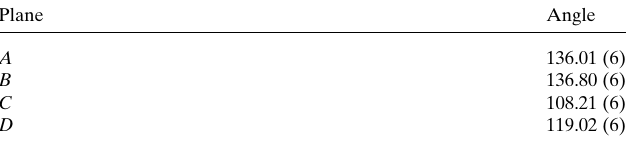
Table 2 Conformation of the four aromatic walls of the calix[4]arene host ( (cid:4) ). A – D are the mean planes passing through the four phenyl moieties of the host. The values reported are the angles formed with the mean plane passing through atoms